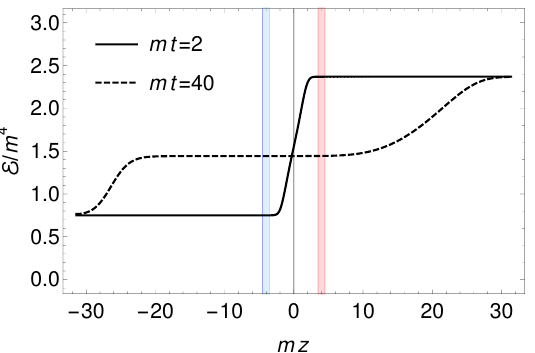
Figure 4: Entangling regions: blue and red stripes are typical arrangements of en- tangling regions of size (cid:96) = 1 that initially reside entirely within the cold and hot bath, respectively. Black solid and black dashed lines are the spatial distributions of the energy density at early ( t = 2) and late ( t = 40) time in units of m = π T and the propagation of entanglement by the rarefaction wave in the right region and compare the